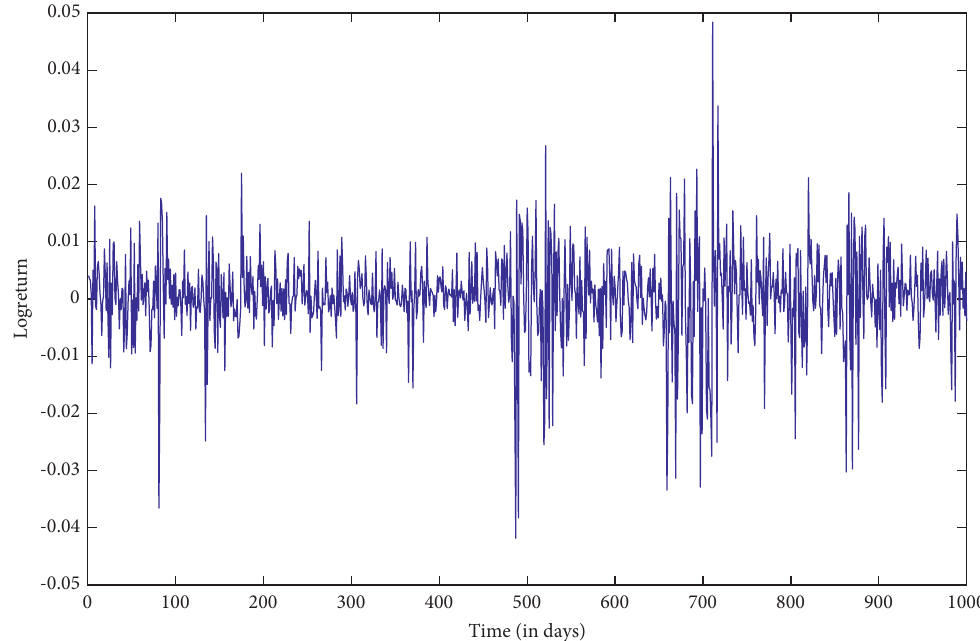
Figure 3: The daily S&P 500 log return series.